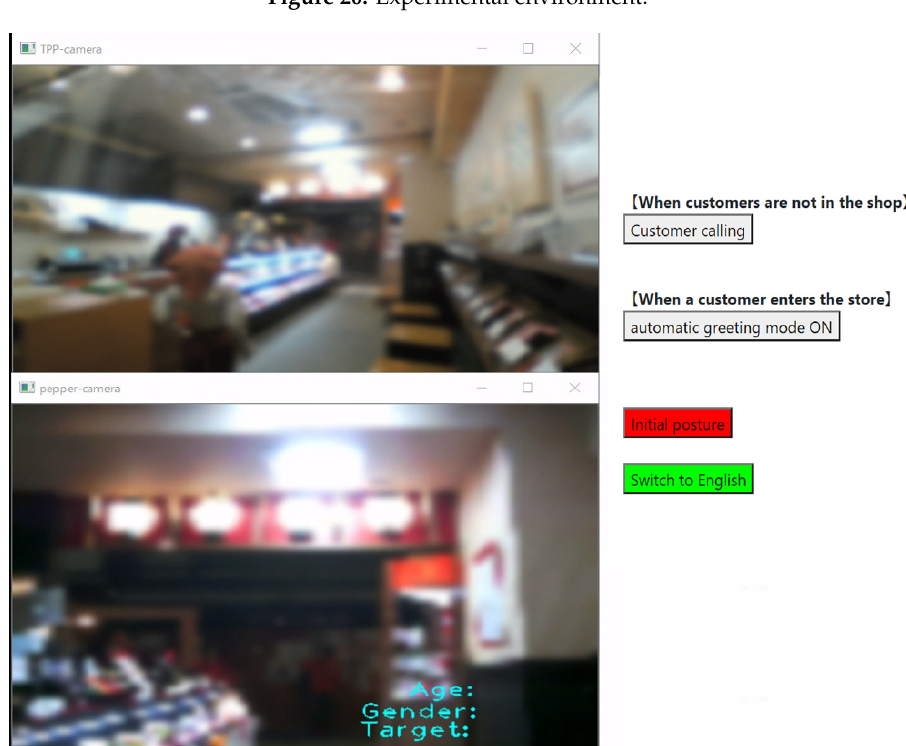
Figure 21. Operation screen.